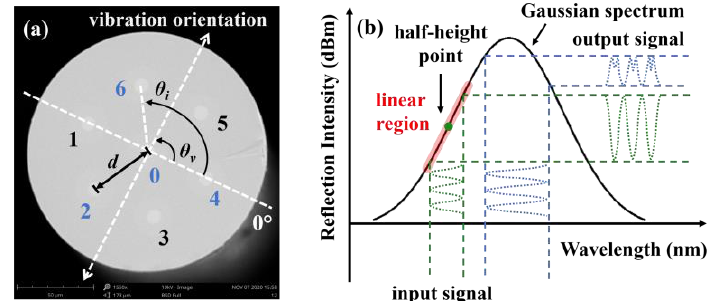
Figure 1. ( a ) Scanning electron microscopy image of the homogeneous SCF with the defined geo- metrical parameters and ( b ) schematic diagram of interrogation.